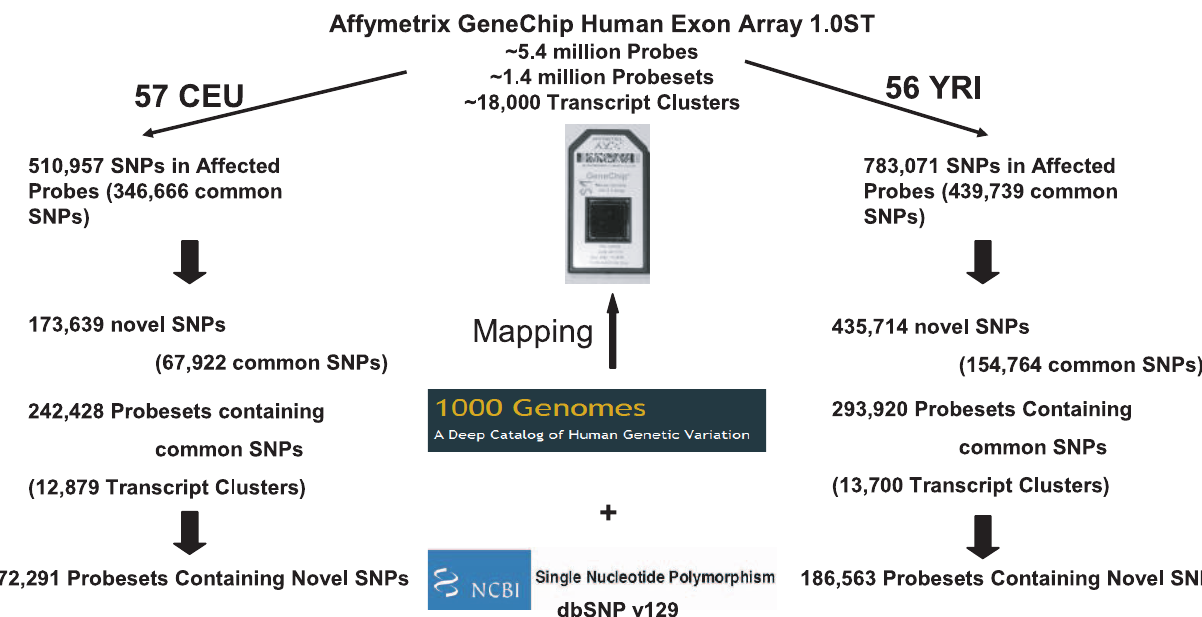
Figure 1. An overview of the methods and major results. The 1000 Genomes Project genotypic data are mapped to the Affymetrix GeneChip Human Exon Array 1.0ST. CEU (Caucasians from Utah, USA) and YRI (Yoruba people from Ibadan, Nigeria) are lymphoblastoid cell lines from the International HapMap Project. Known SNPs are those recorded in the NCBI dbSNP v129 database. Common SNPs are those with minor allele frequencies greater than 5%. Within the exon array, probesets are exon-level and transcript clusters are gene-level.